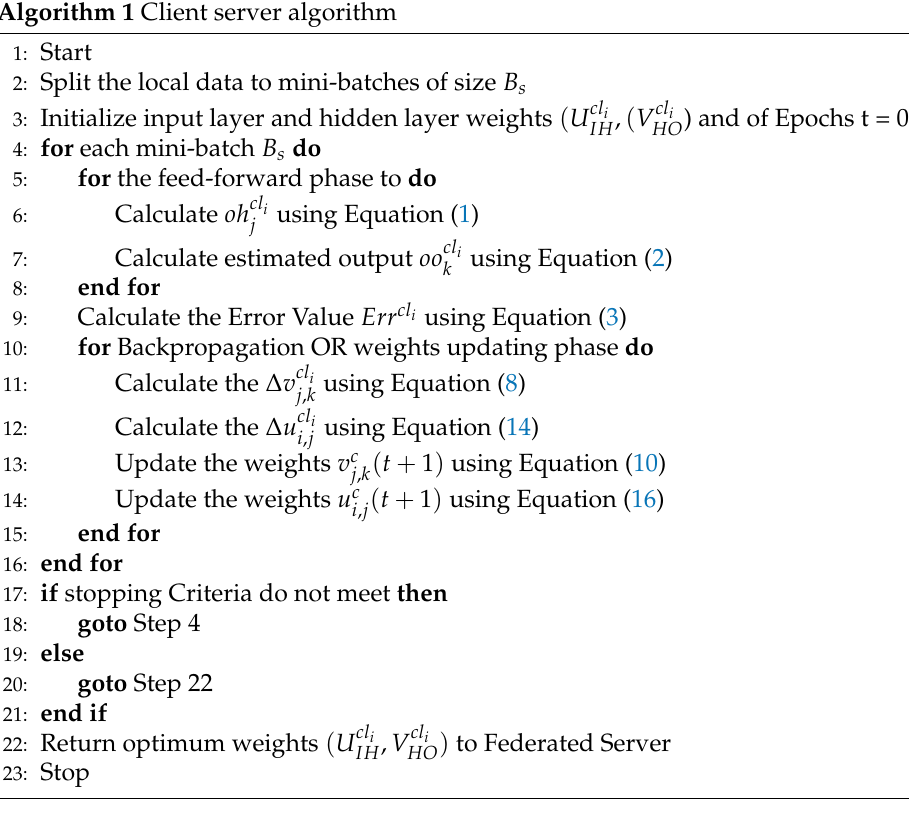
Algorithm 1 Client server